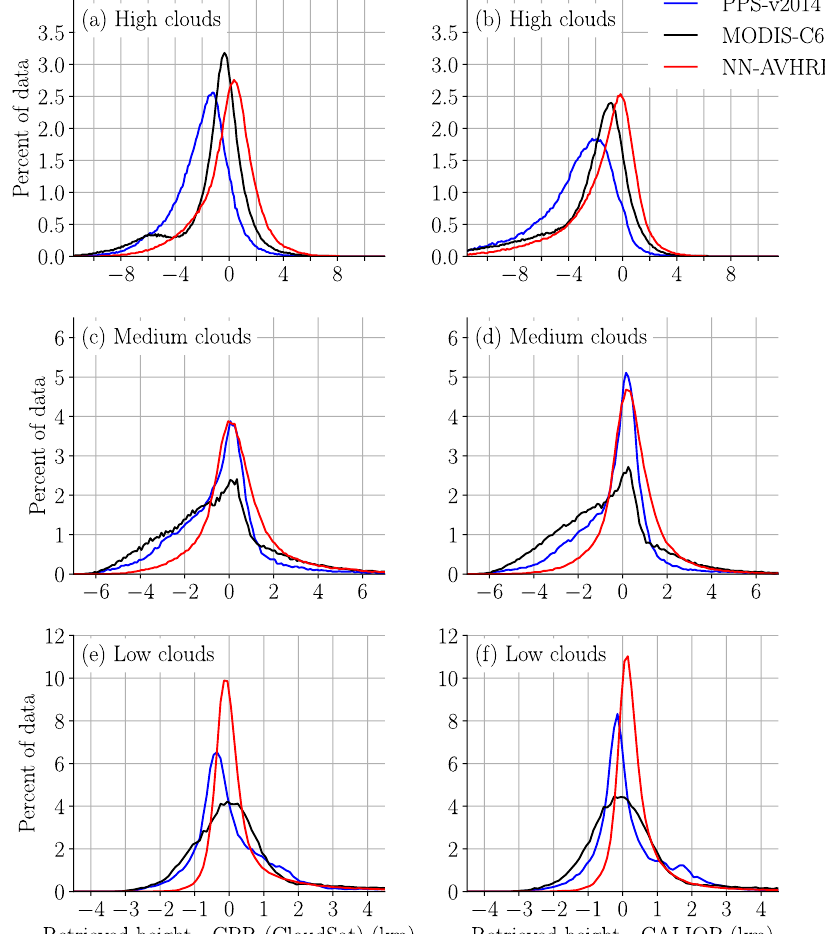
Figure 6. Error distribution compared to CPR (CloudSat) (a, c, e) and CALIOP (b, d, f) . The percent of data is calculated in 0.1km bins. For CALIOP the low, medium and high clouds are determined from CALIOP feature classification flag. For CPR (CloudSat) the low, medium, high clouds are determined from CPR (CloudSat) height compared to NWP geopotential height at 440 and 680hPa. The final validation dataset (see Table 1) where all algorithms had a height reported is used. Note that the values on the y axis are dependent on the bin size. The peak at 11% for NN-AVHRR in (f) , means that 11% of the retrieved heights are between the CALIOP height and the CALIOP height +